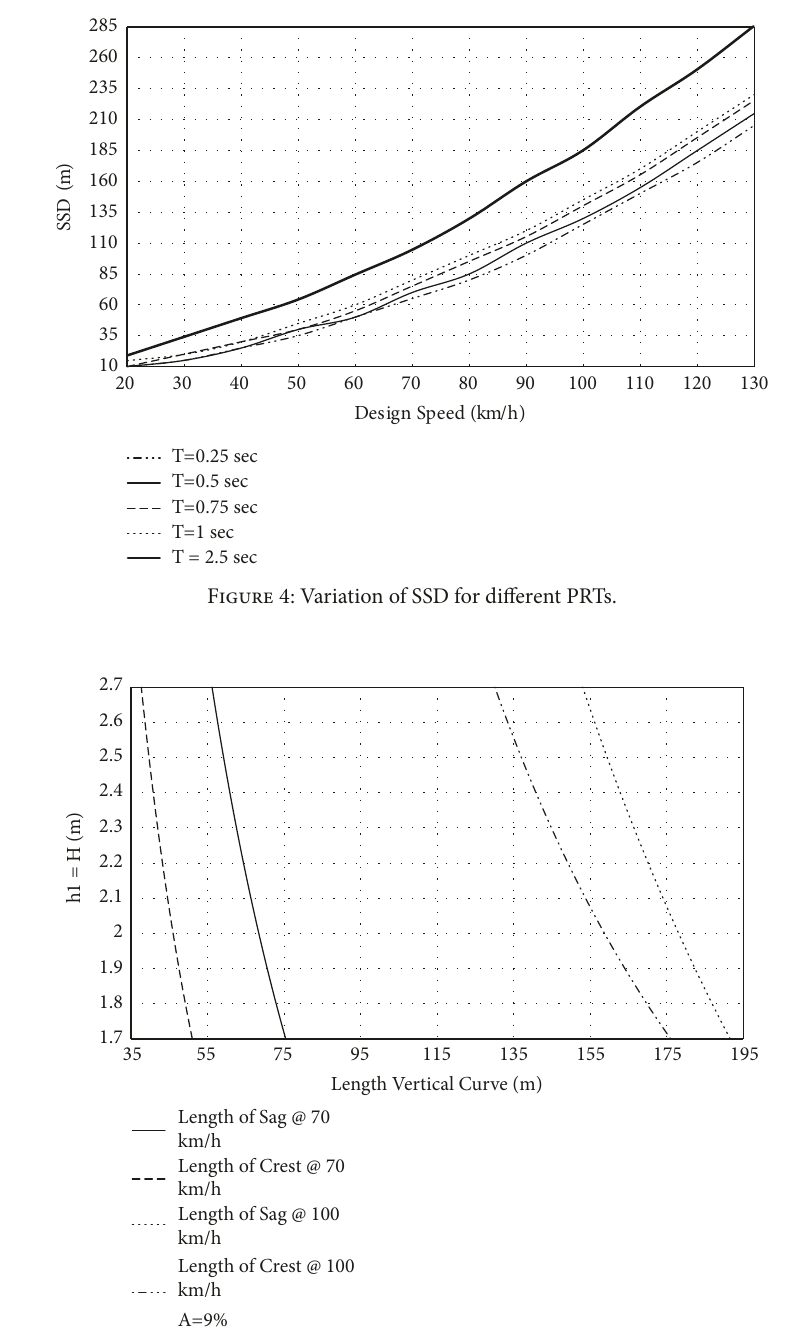
Figure 5: Variation of vertical curve length at different values of h1 and